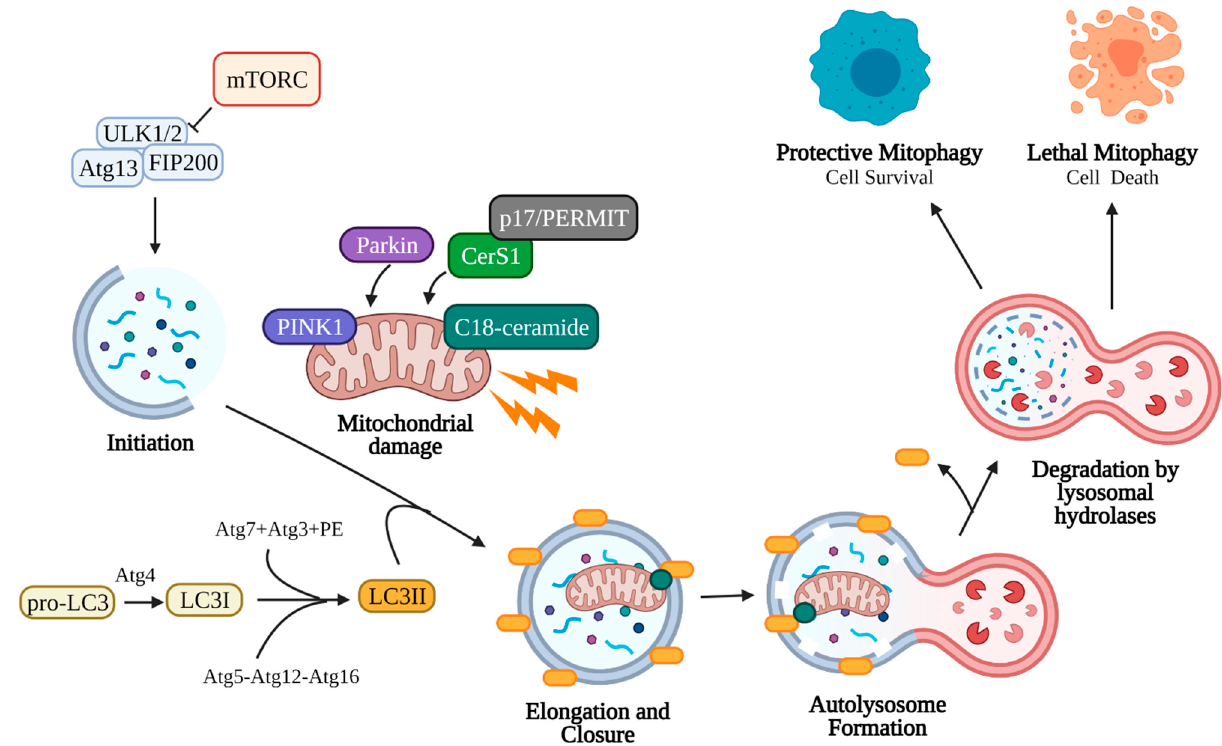
Figure 2. Canonical mitophagy pathway. Damaged mitochondria signal the need for removal by retaining PINK1 on the outer mitochondrial membrane, which recruits cytosolic Parkin and p62. Parkin ubiquitinates outer mitochondrial mem- brane proteins, allowing p62 recruitment and direct binding to LC3II. LC3II is an essential component of the autophagosome double-membrane and regulates its elongation and curvature. LC3II is formed following cleavage of the C-terminal by Atg4, and LC3I is subsequently conjugated to phosphatidylethanolamine (PE) by Atg7, Atg3, and the Atg5-Atg12-Atg16 complex. Elongation of the autophagosomal membrane occurs around the mitochondria until it is fully engulfed. The autophagosome is then trafficked to the lysosome, where the outer autophagosomal membrane fuses with the lysosome. Internal components, including the mitochondria, are degraded and recycled by lysosomal hydrolases (cathepsin B, D, L). Mitophagy may assist the cell in reducing stress (protective mitophagy resulting in cell survival) or in inducing cell death (lethal mitophagy). Created with BioRender.com (accessed on 11 May 2021).